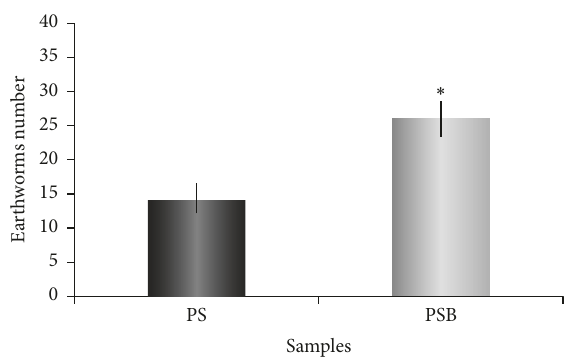
Figure 1: Earthworms avoidance test . Number of earthworms ( Lum- bricus terrestris L.) recovered in unfertilized (PS) versus unfertilized plus biochar (PSB) soil compartments after 48 h. Vertical bars rep- resent the standard error of the mean of three replicates of 40 earth- worms each. Asterisks indicate significant differences ( 𝑝 ≤ 0.05